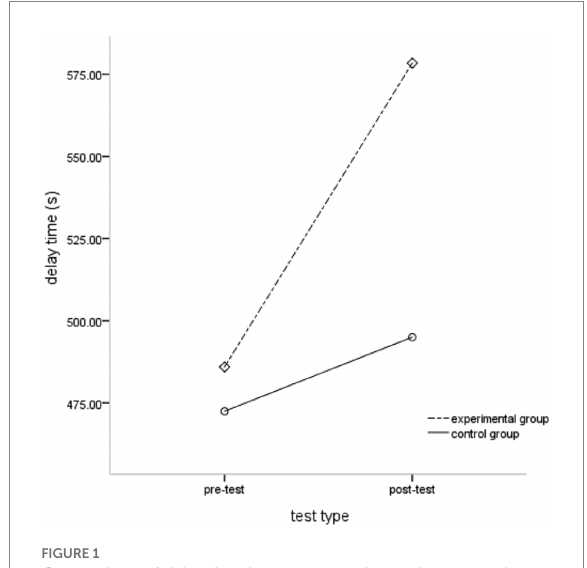
FIGURE 1 Comparison of delay time between experimental group and control